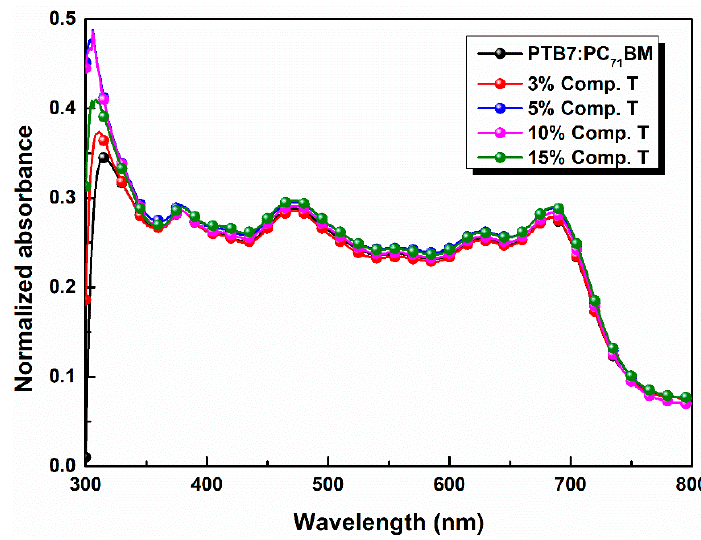
Figure 3. Normalized UV-vis absorption spectra of PTB7:PC 71 BM blends incorporating compound T in different concentrations.